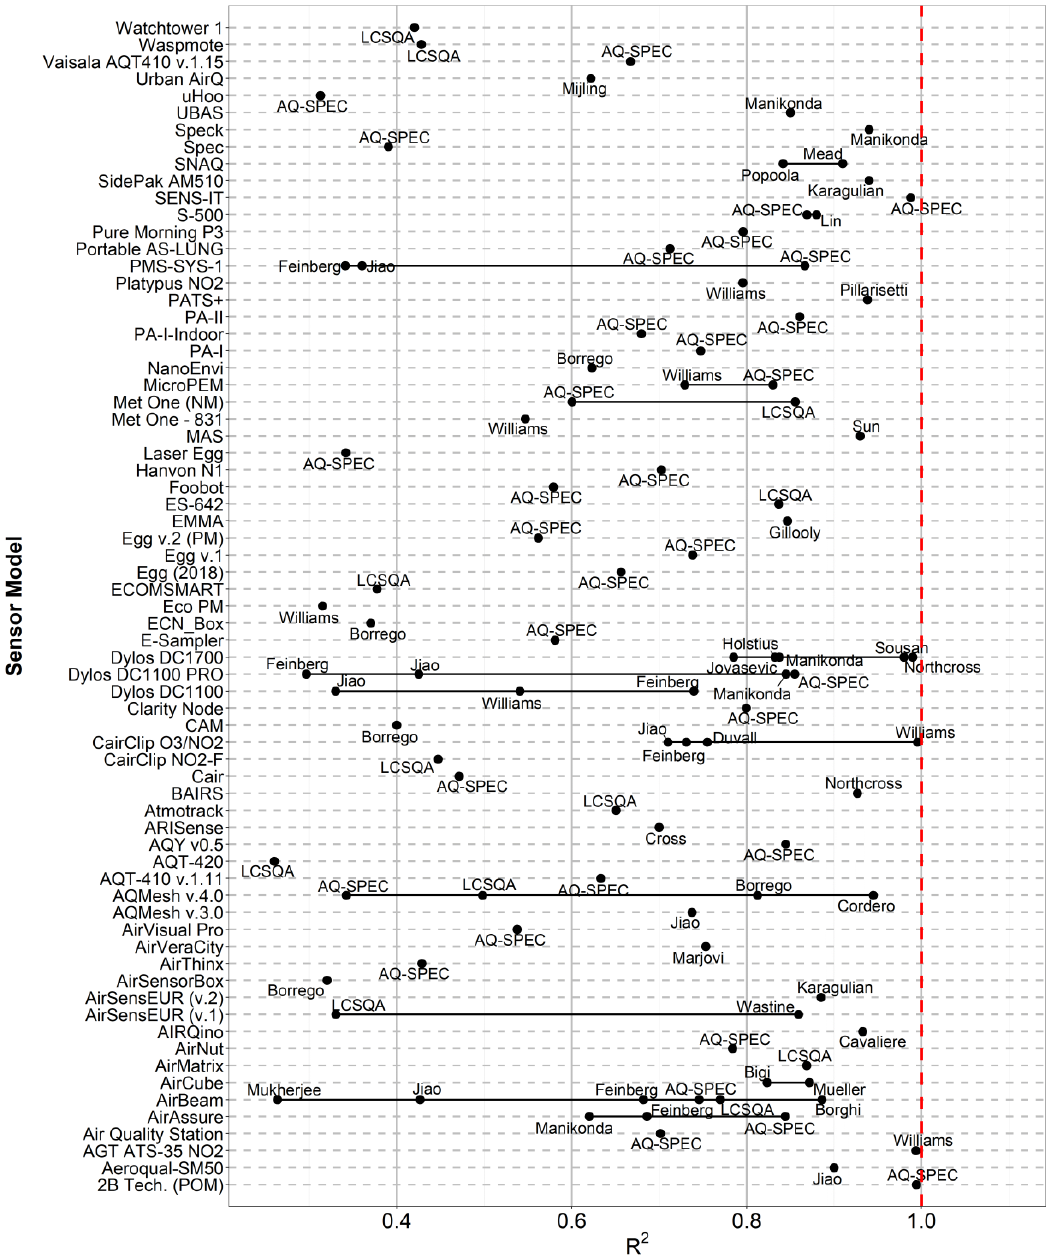
Figure 4. Mean R 2 obtained from the comparison of SSys against reference measurements at all averaging times (1 min, 5 min, 1 h, and 24 h). The author name below each bullet gives the first author of the publication from which results were drawn.